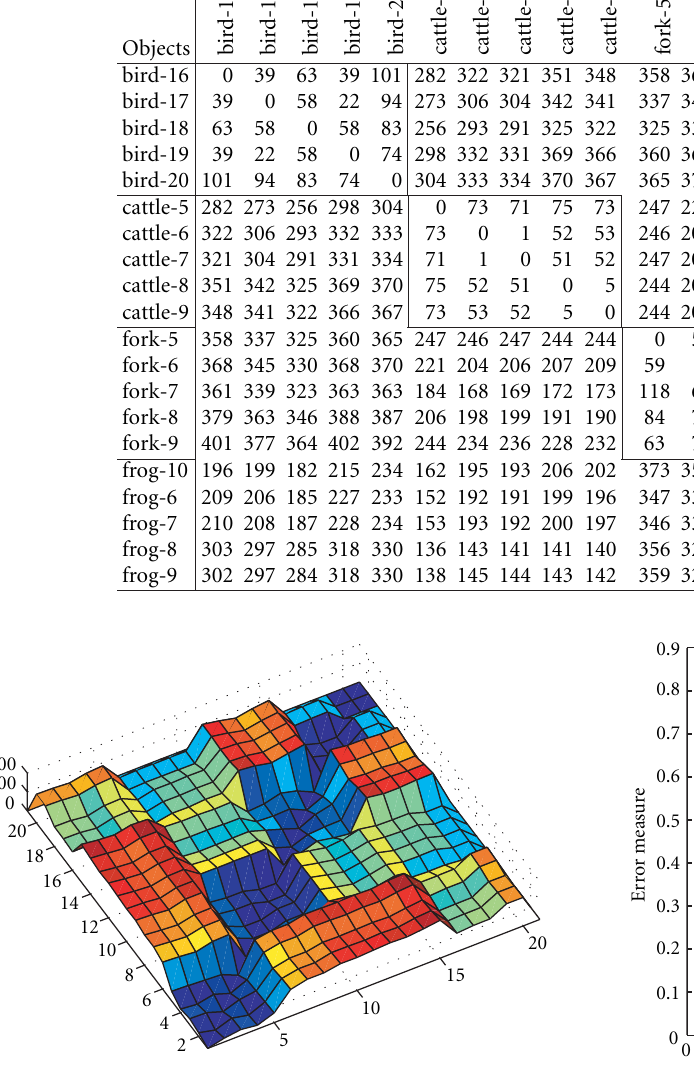
Figure 9: Similarity scores obtained for the contours in test set 2 presented in Figure 7.